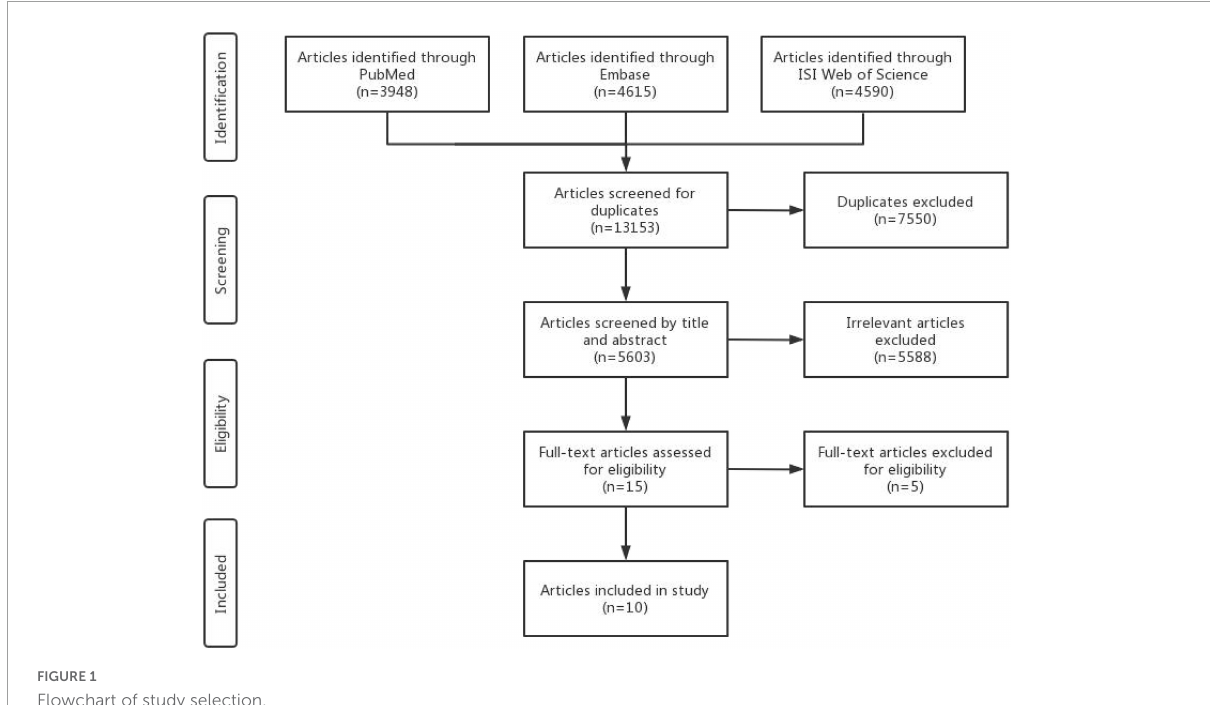
FIGURE1 Flowchart of study selection.